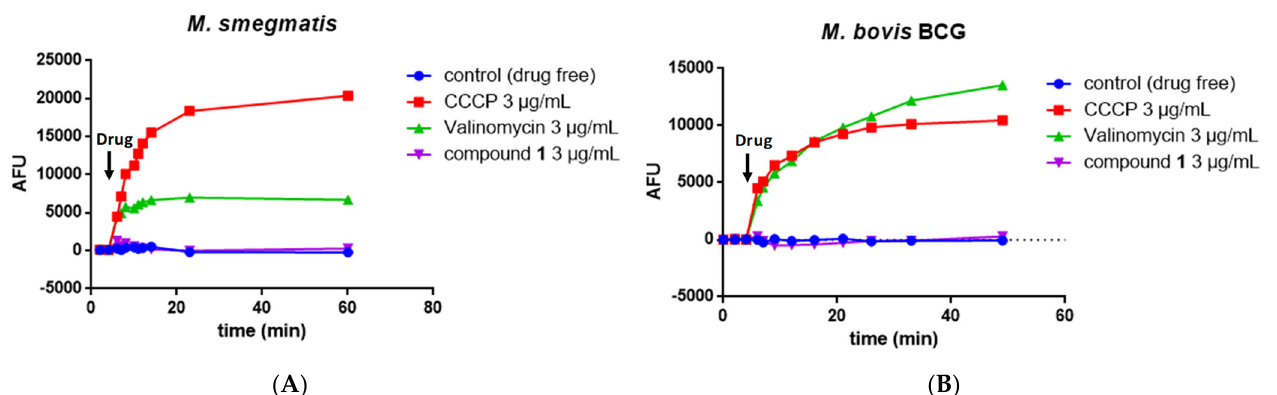
Figure 5. Effect of compound 1 on the mycobacterial transmembrane potential. Fluorescence of DiSC3(5) over time following the addition of DMSO (negative control), CCCP, valinomycin, or compound 1 to M. smegmatis ( A ) and M. bovis BCG ( B ). Membrane depolarization was measured using the membrane potential-sensitive fluorescent dye DiSC3(5), measured at λ ex 622 nm/ λ ex 670 nm.